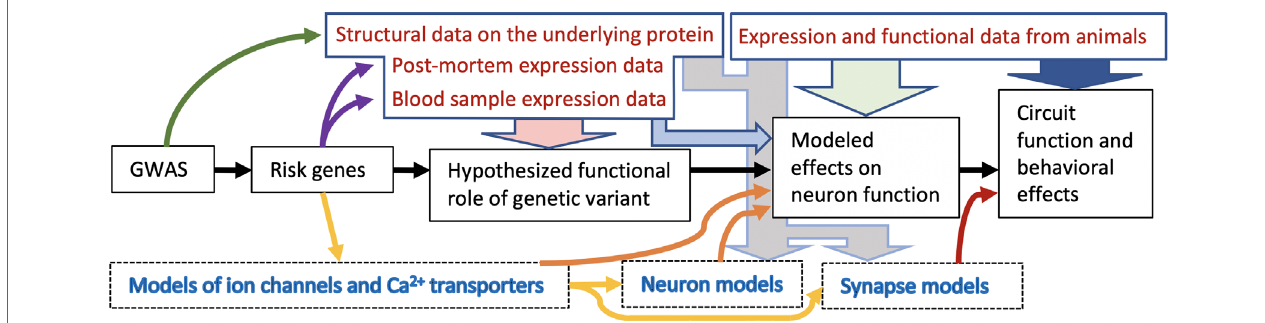
FIGURE 1 | Schematic illustration of the biophysical psychiatry approach for studying heritable mental disorders. This approach typically consists of five main stages ranging from initial GWAS to prediction of the effects of genetic variants on circuit functions (black arrows). First, the results from GWASs are used to identify risk variants and risk genes. Data from patients and structural genomics can be used to constrain the range of possibilities how these variants affect the protein functions: Is there evidence of altered expression of these proteins in the patients and in what tissue (purple arrows)? Are the identified SNPs likely to affect the protein structure (dark green arrow)? This type of information is important for formulating an initial hypothesis on the functional role of the variant (light red arrow), and importantly, together with data from functional genomics, it can be used for computational models of neurons or ion channels as well as other proteins affecting the function of the neuronal circuit (yellow arrows). The effects of the risk gene variants on neuron function can be predicted with the models (orange arrows). When these effects are implemented in a network model that describes both neuronal activity and synaptic communication between the neurons, the impact of the variants on circuit and/or behavioral functions can be predicted (dark red arrow). In case the genetic background of the disease is not known or it is not possible to directly link the genetic variant effects to all desired aspects of the model behavior, cellular-level data from patients or animal model studies can be used as a shortcut and make the model express the dichotomy suggested by the experiments (light grey arrows). Lastly, data from animal studies can be used to validate the model: Is the studied neuron type really behind the modelled phenotype (light green arrow)? Are the genes in which the modelled variants are located expressed in the particular neuron type (light blue arrow)? Are there behavioral observations in animal model studies that support the conclusions (dark blue arrow)? These are but few questions to consider in a modelling approach bridging the gap between genes and